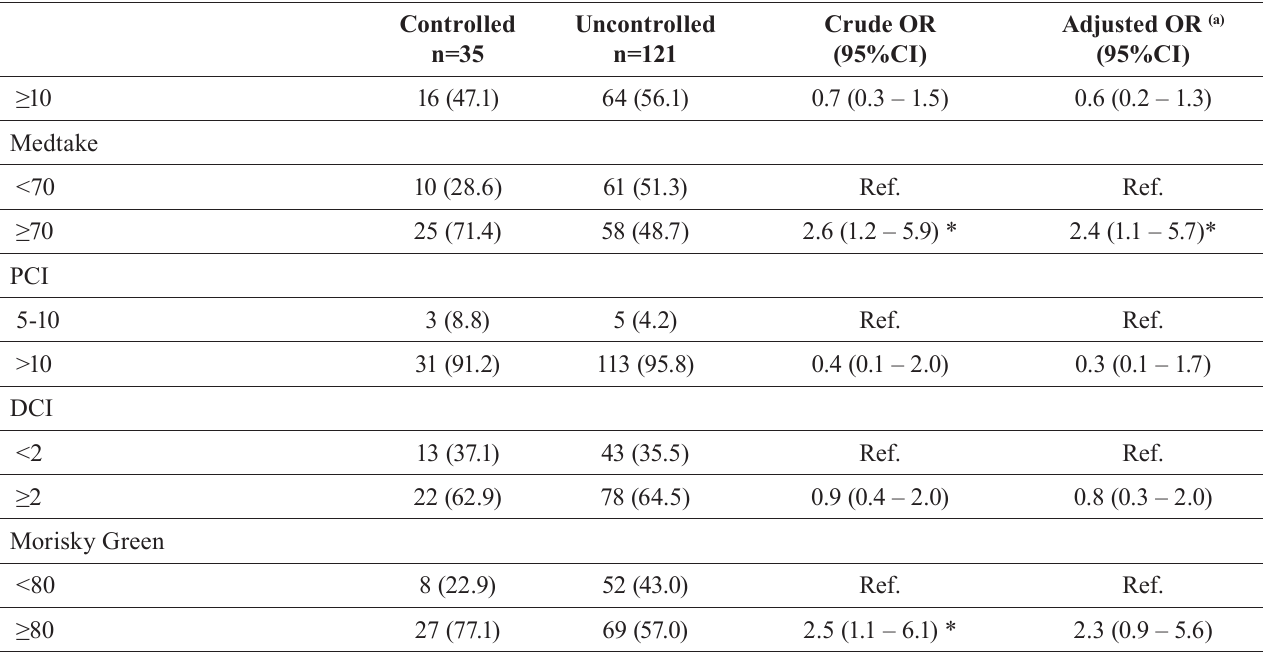
Legends:(a) adjusted OR for gender, age and time of diagnosis, MT = Medtake, PCI = Pharmacotherapy Complexity Index, DCI = Diabetes Complication